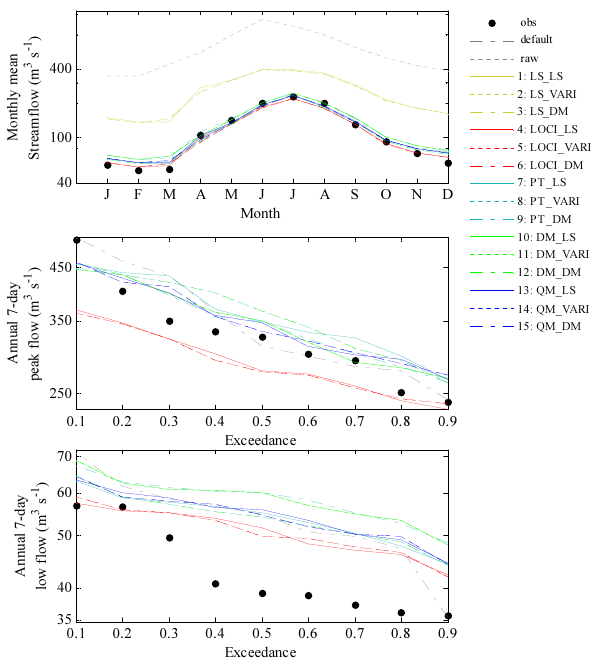
Figure 8. Monthly mean streamflow (top) and exceedance probabil- ity curves of annual 7-day peak flow (middle) and annual 7-day low flow (bottom) during 1986 ∼ 2001 in the Kaidu River basin (obs: observed streamflow; default: simulated with observed meteorolog- ical data; raw: simulated with RCM-simulated meteorological data; 1–15: simulated with corrected RCM meteorological data listed in Table